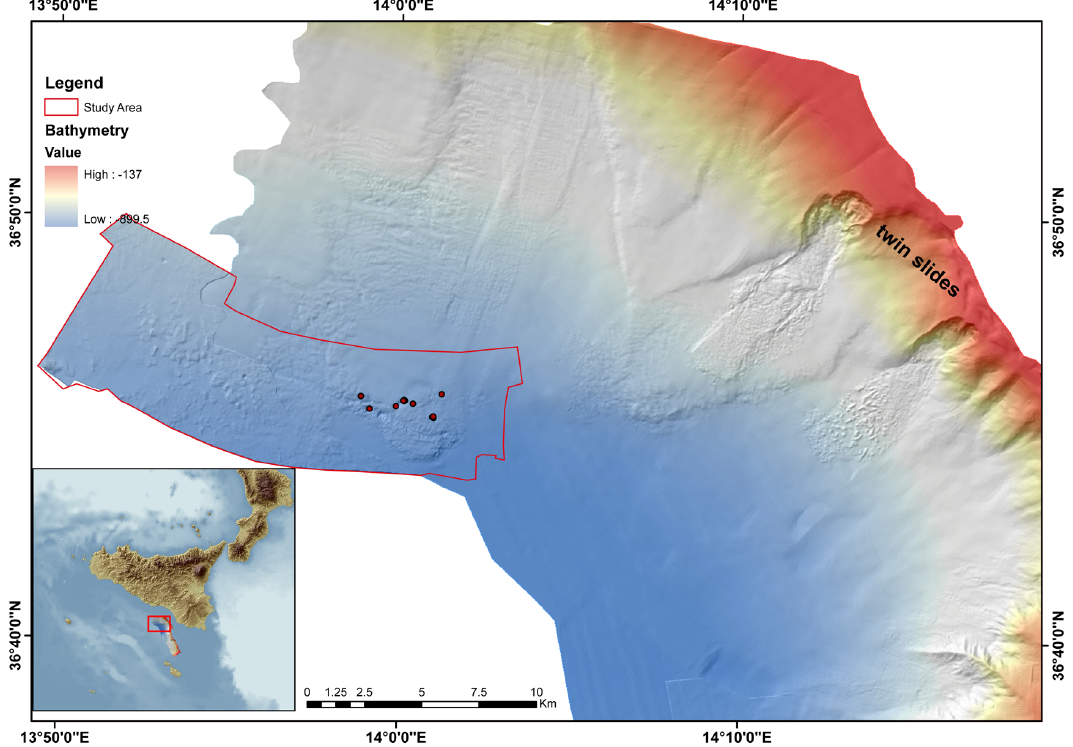
Fig. 1. Map showing the shaded relief Digital Terrain Model (DTM of 20m resolution with 10 × vertical exaggeration) of the Gela Basin in the Strait of Sicily. The figure illustrates the location of the pockmarks field discussed in this article (red spots represents major pockmarks); inset, the Mediterranean basin with rectangle showing the same area magnified in the